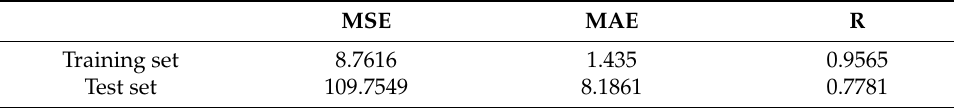
Figure 5. LM-ANN model fitting. Table 6. Evaluation metrics for training set and test